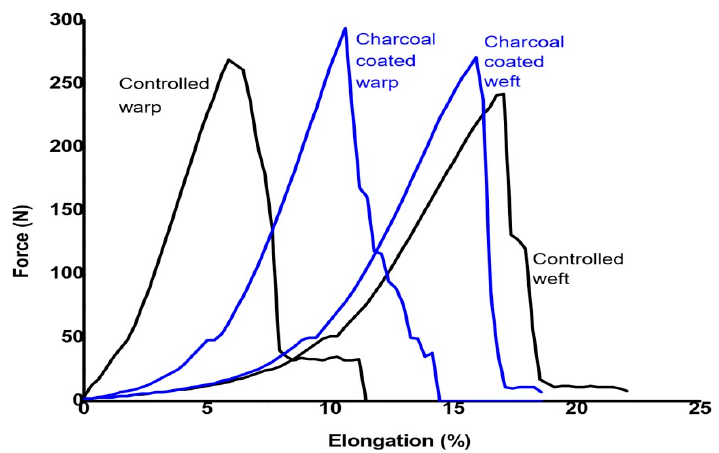
Figure 7. Mean tensile strength and breaking elongation of controlled and charcoal coated samples.